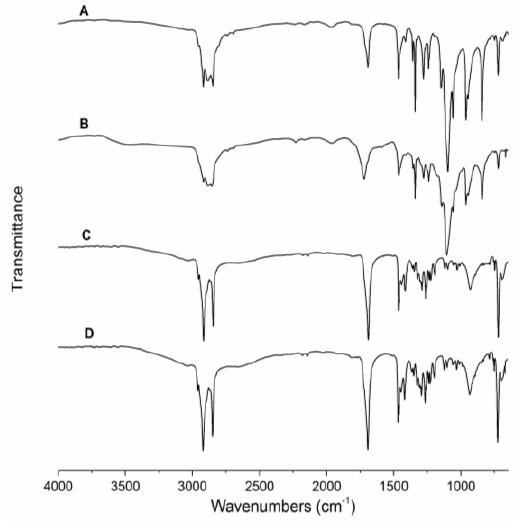
Figure 6. Fourier transform infrared spectroscopy (FT-IR) spectra of PEO-PDA fibers and PDA polymers. The signals correspond to: blue PEO-PDA fibers ( A ), red PEO-PDA fibers ( B ), blue PDA ( C ), and red PDA ( D ).